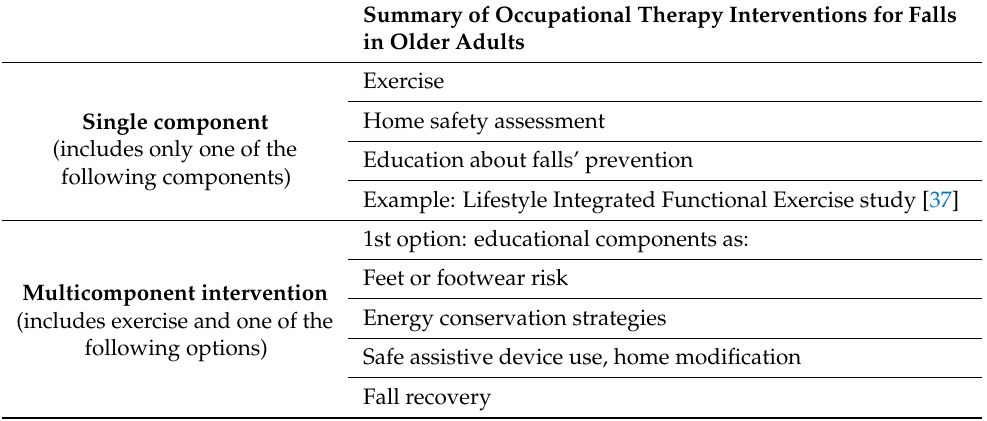
Table 1. Summary of occupational therapy interventions for falls in older